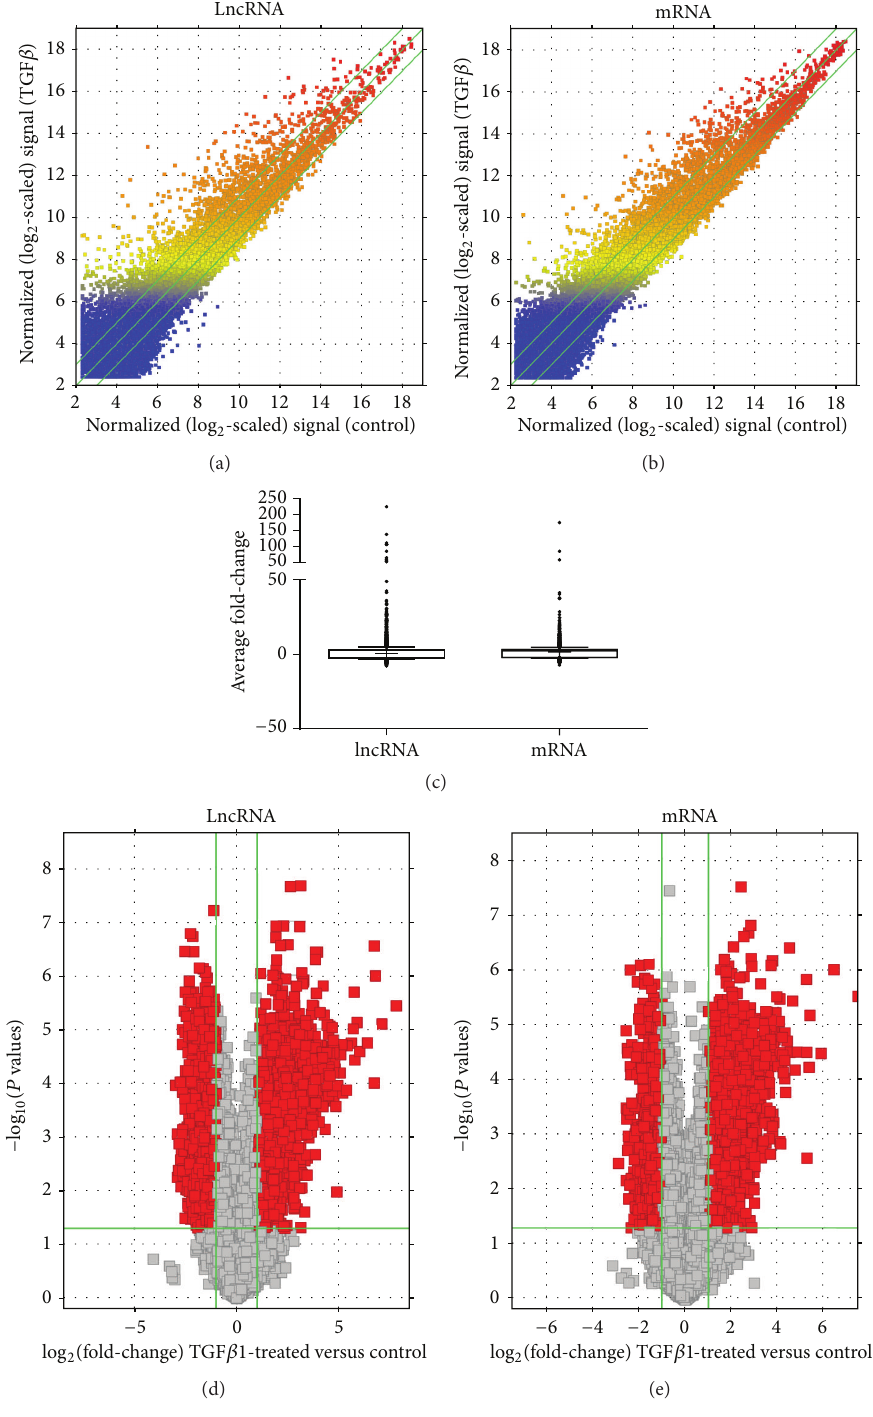
Figure 1: LncRNA and mRNA expression profiles in HUVECs exposed to TGF 𝛽 1 (10ng/mL) versus control. (a and b) Scatter plots comparing the variation in lncRNA and mRNA expression. The values plotted are the averaged normalized signal values (log 2 scaled) for the control ( 𝑥 -axis) and the TGF 𝛽 1 treatment ( 𝑦 -axis) groups. The green lines indicate fold-change. LncRNAs and mRNAs above the top green line and below the bottom green line exhibit at least a 2.0-fold difference between the two study groups. (c) Box-and-Whisker plots (10th and 90th percentiles) showing average fold-change of lncRNAs and mRNAs. Median intensity is denoted with a “ − ” sign and mean intensity is denoted with a “+” sign. (d and e) Volcano plots detailing magnitude of expression difference. The vertical green lines correspond to 2.0-fold upregulation and 2.0-fold downregulation of expression. The horizontal green line indicates a 𝑃 value of ≤ 0.05. Red points represent lncRNAs and mRNAs with statistically significant differential expression (fold-change ≥ 2.0, 𝑃 ≤ 0.05